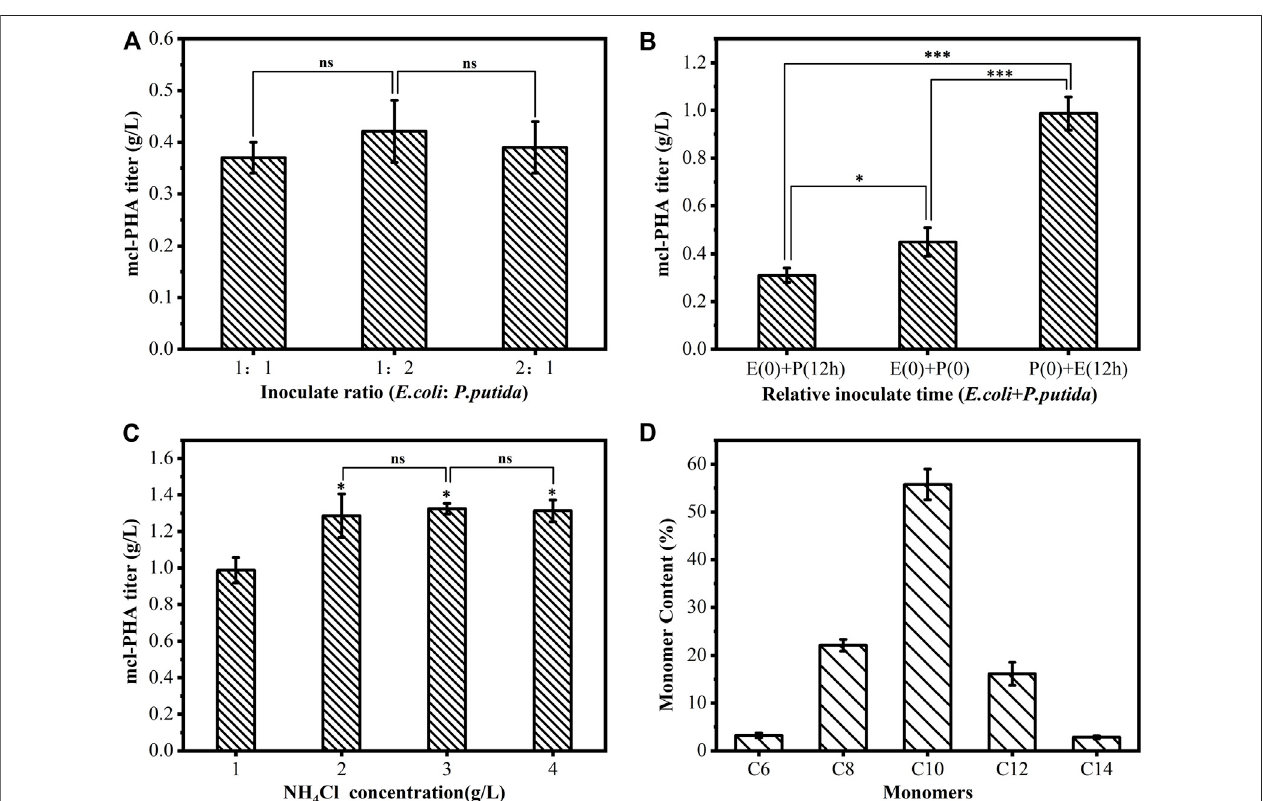
FIGURE 7 | The arti fi cial microbial consortium with optimized inoculation ratio, inoculation time, and nitrogen source was used to convert a mixture of glucose and xylose(mass ratio (cid:2) 1:1) intomcl-PHA in the bioreactor, and the cultivation time was 60 h (A) Different inoculation ratios (vol/vol) (B) Differentrelativeinoculation times; E (0) +P (12 h), P. putida inoculated12 h after inoculationwith E.coli ;E (0)+P (0),Simultaneous inoculation of E.coli and P. putida ; P(0) +E(12 h), E. coli inoculated 12 h after inoculation with P.putida (C) Differentnitrogen source concentrations (D) The monomer compositionofmcl-PHA produced bythemicrobialconsortium. The error bars indicate the standard deviation of triplicate experiments. * p < 0.05; ** p < 0.01; *** p < 0.001; ns, no signi fi